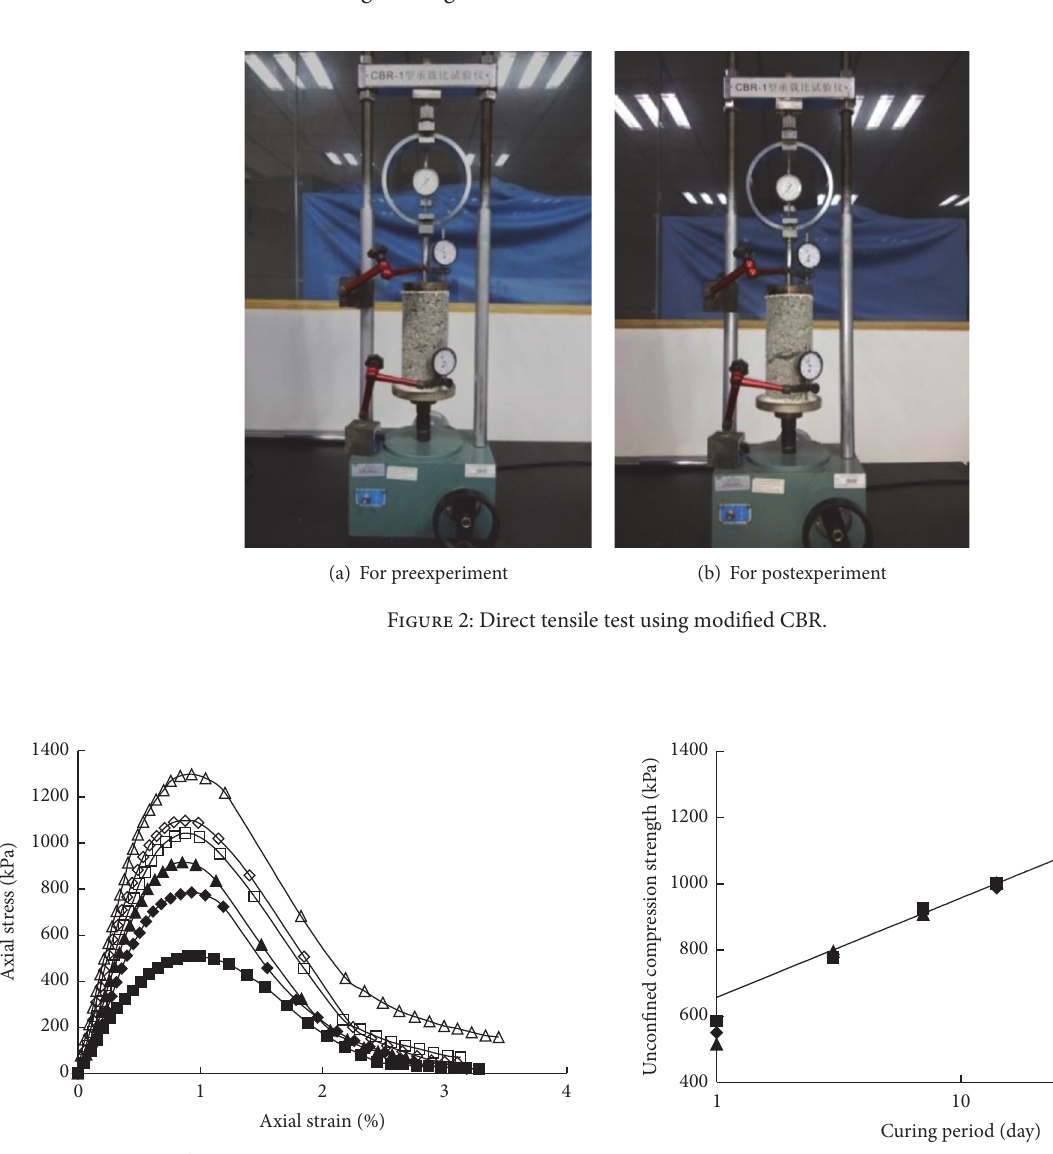
Figure 4: Relationship of unconfined compressive strength-curing